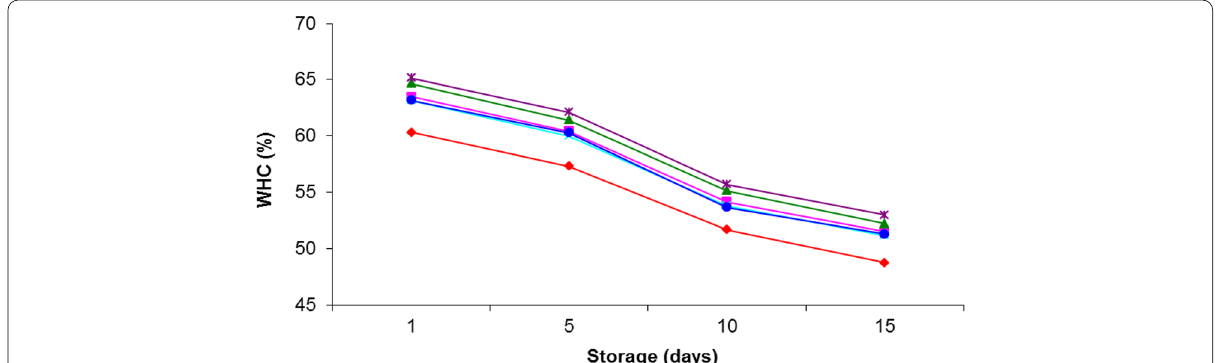
Fig. 2 Water‑holding capacity of probiotic and non‑probiotic yoghurt made from ewes’ milk fed a diet supplemented with Spirulina platensis or fish oil during storage at 5 2 °C for 15 ±